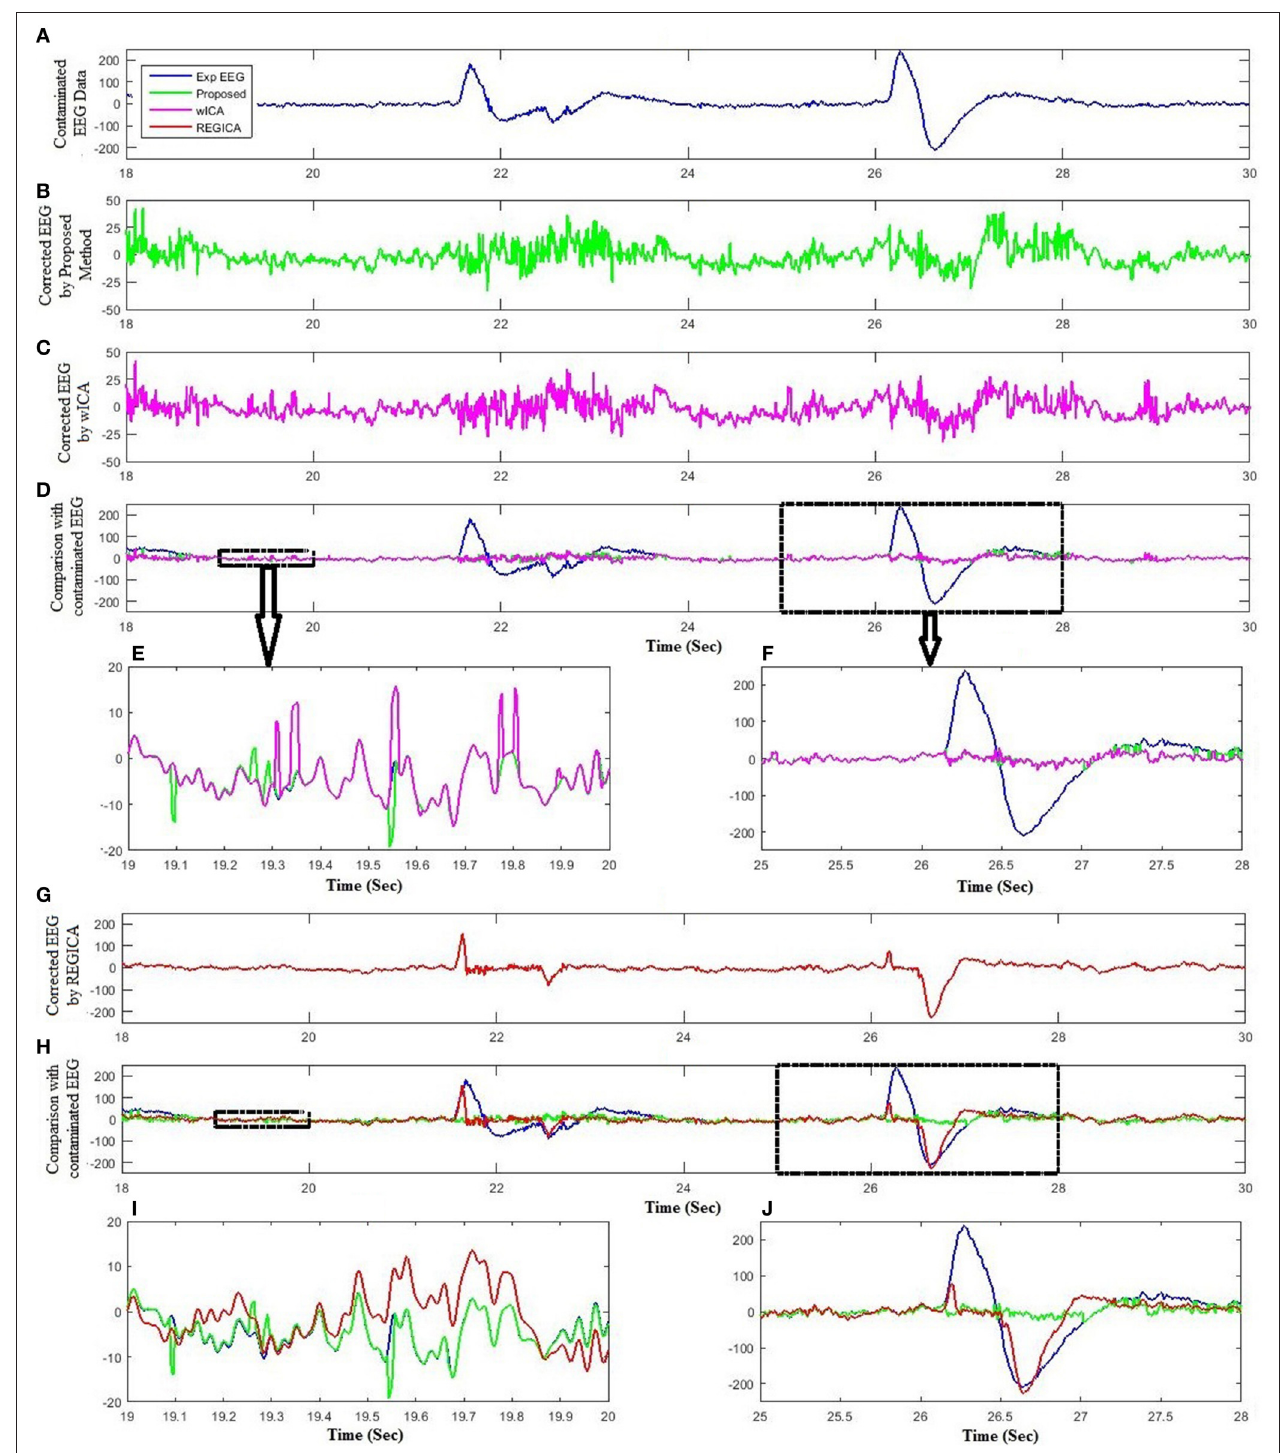
FIGURE 7 | Comparison of the proposed method with wICA and REGICA using experimental dataset. (A) Experimental EEG data. (B) Reconstructed EEG by the proposed method. (C) Reconstructed EEG by wICA. (D) Comparison of the proposed method and wICA reconstructed EEG with experimental EEG. (E) Partial enlargement of non-artifactual region. (F) Partial enlargement of artifactual region. (G) Reconstructed EEG by REGICA. (H) Comparison of the proposed method and REGICA reconstructed EEG with experimental EEG. (I) Partial enlargement of non-artifactual region. (J) Partial enlargement of artifactual region.